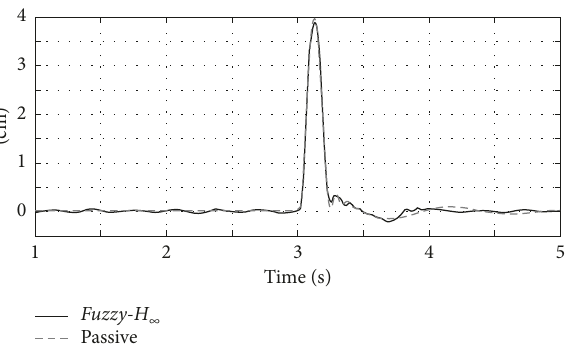
Figure 13: Rear tire displacement ( Z